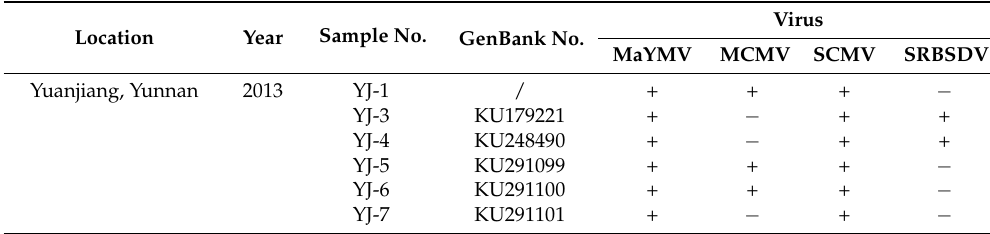
Table 1. Detection of mixed infections in maize samples collected from Yunnan region of China.